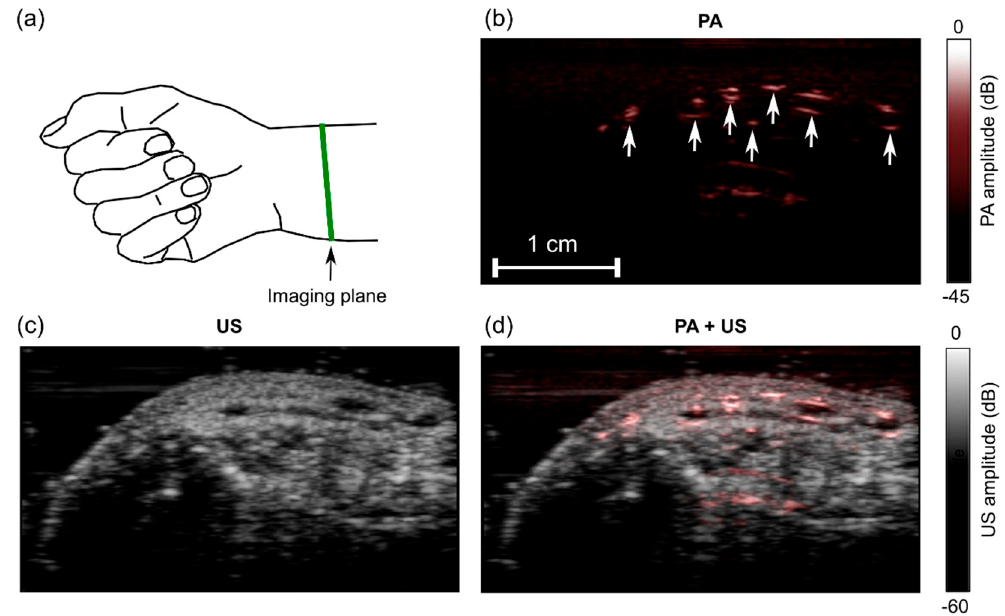
Figure 7. Photoacoustic (PA) and ultrasound (US) images of a wrist of a human volunteer. ( a ) Schematic indicating the location of the imaging plane; ( b ) PA image; ( c ) US image; ( d ) PA + US image overlay. In the PA image ( b ), the prominent signals likely originated from blood vessels (arrows). Images were reconstructed and displayed in real-time on logarithmic scales. Here, they are presented without the uppermost 5 mm, which contained the ultrasound gel. Bulk tissue motion and localized pulsatile subsurface motion were apparent in the corresponding video (Supplementary Materials; Video S3).